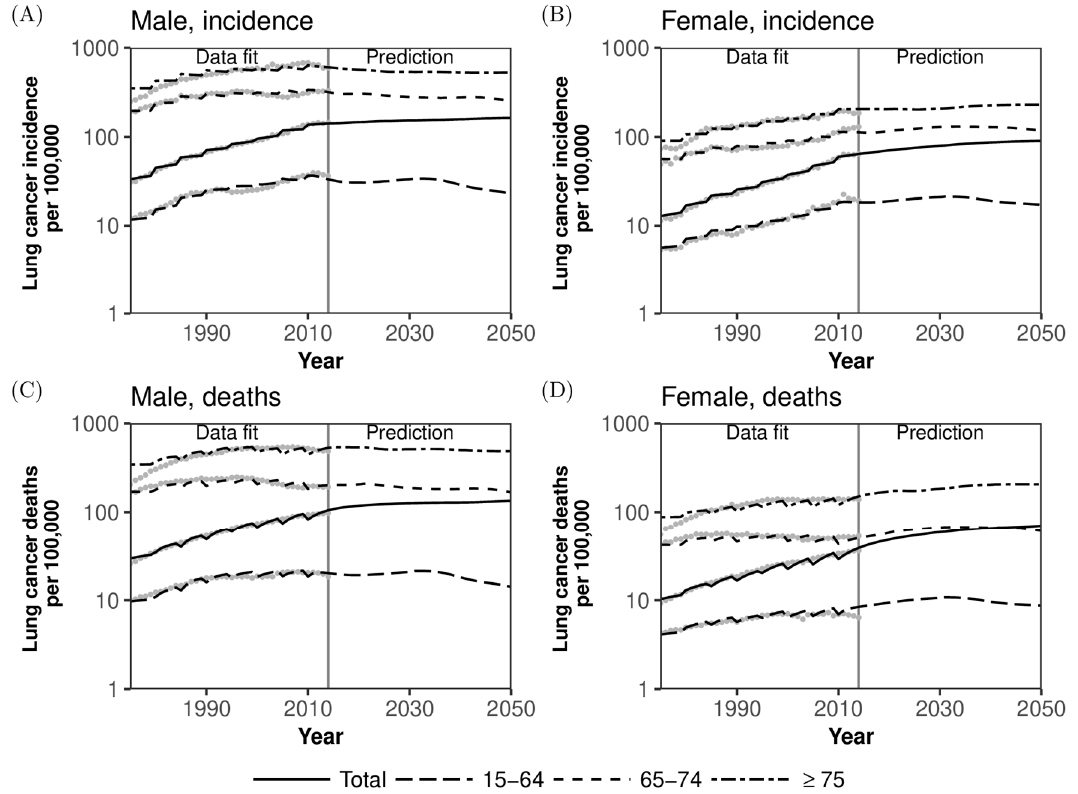
Figure A1. Comparison between observed and predicted lung cancer incidence and mortality per 100,000 population in Japan. Note that the vertical axis is in logarithmic scale. Comparisons between observed and predicted lung cancer incidence and mortality per 100,000 population are made by age group and sex. ( A ) Lung cancer incidence in men, ( B ) Lung cancer incidence in women, ( C ) Mortality in men, and ( D ) Mortality in women. Bold dashed line represents working-age population aged 15–64 years, thin dashed line corresponds to those aged 65–74 years, uneven dashed line represents those aged 75 years or older, and solid line represents the entire population. Grey dots before 2014 were used to estimate model fitting parameters via the maximum likelihood method, and lines for 2015 and later are predictions calculated using maximum likelihood estimates at the latest time. The 95% confidence intervals are omitted from predictions because of the narrow uncertainty bounds.